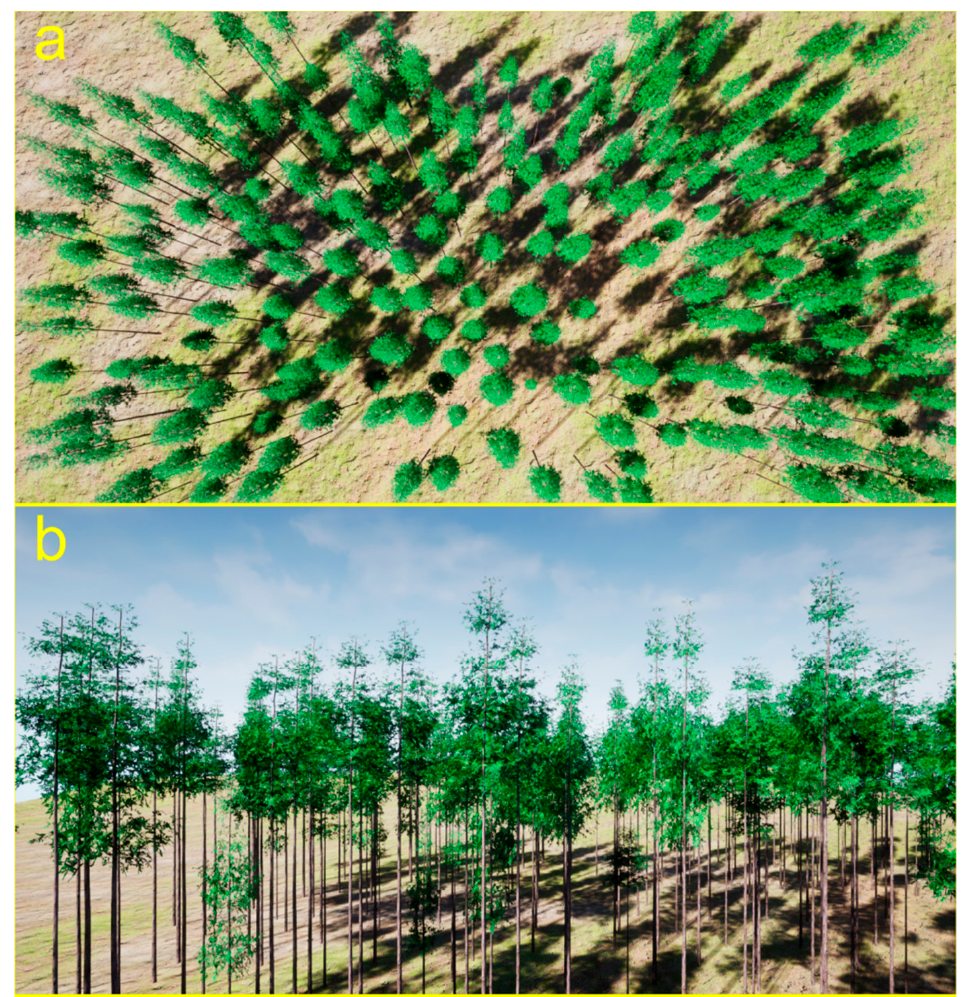
Figure 10. Visual simulation results of a 23-year-old Chinese fir plantation. ( a ) Top view angle to observe the crown width extrusion and competition between trees in the stand. ( b ) Side view angle to observe the differences between UBH, H, CW and CL of different